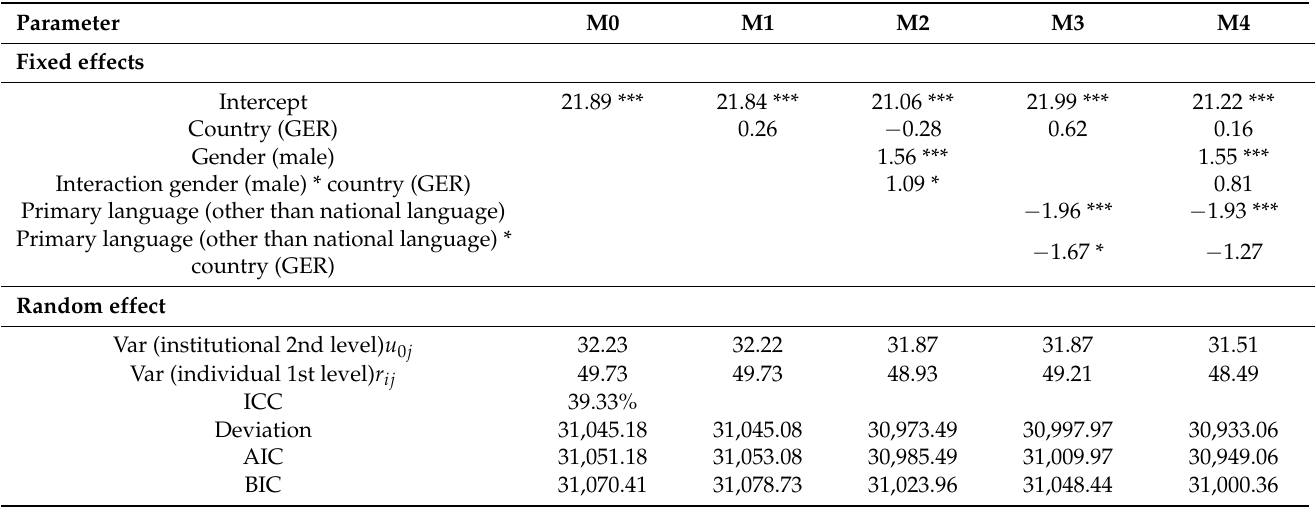
Table 4. Results from Multi-Level